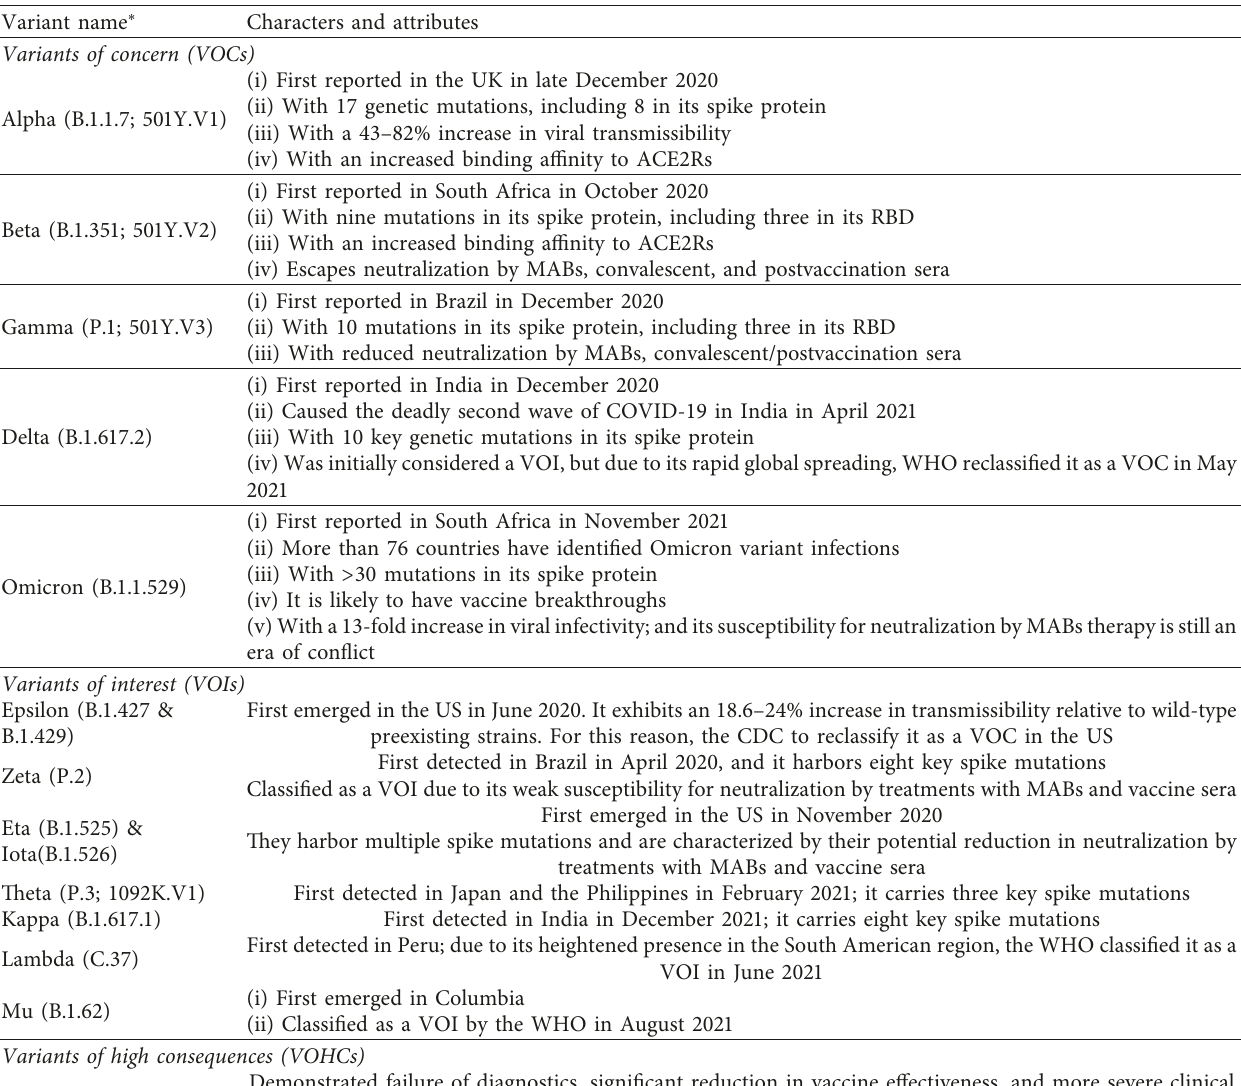
Table 2: SARS-CoV-2 new variants [17,